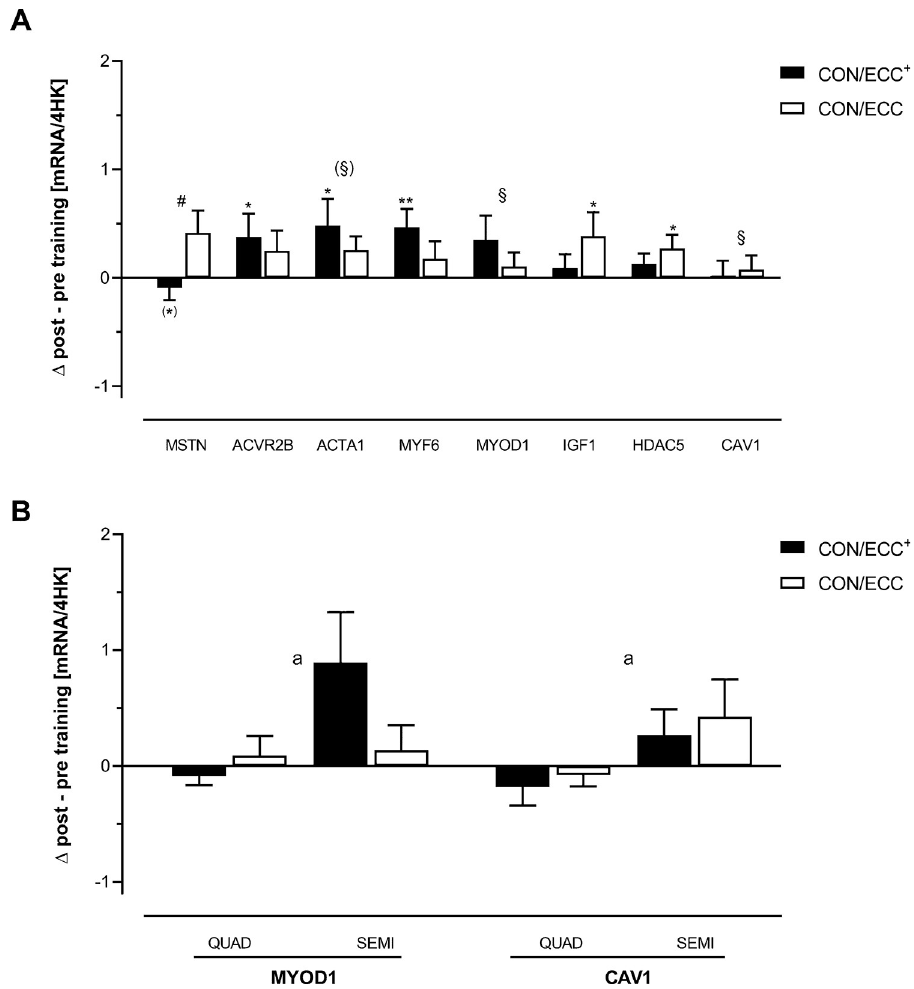
Fig 1. A. Significantly changed marker mRNAs encoded by genes involved in skeletal myogenesis and skeletal muscle hypertrophy. B. Significantly changed marker mRNAs encoded by genes involved in skeletal myogenesis and skeletal muscle hypertrophy significantly affected by the type of autograft. These are relative values based on an aggregate of 4 housekeeping (HK) transcripts. Mean ± SE are shown. #: Significant group x time effect (p < 0.05); §: Significant time effect (p < 0.05); (§): Tendency (p = 0.059) towards a time effect; � : p < 0.05, �� : p < 0.01 compared to the respective baseline value; ( � ): Tendency (p = 0.072) for a difference compared to the respective baseline value; a: Significant effect of the type of autograft (p <